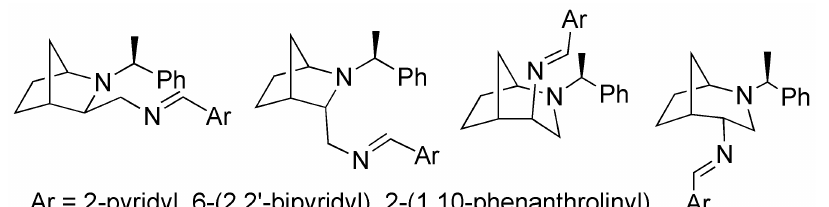
Figure 2. Structure of modular chiral catalysts based on 2-azabicycloalkanes.